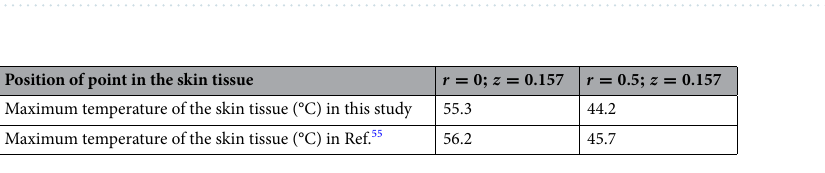
Exposure time (step time) Maximum temperature of the skin tissue (°C) 43.8 Table 2. The maximum temperature of the skin tissue obtained in this study for different exposure times.